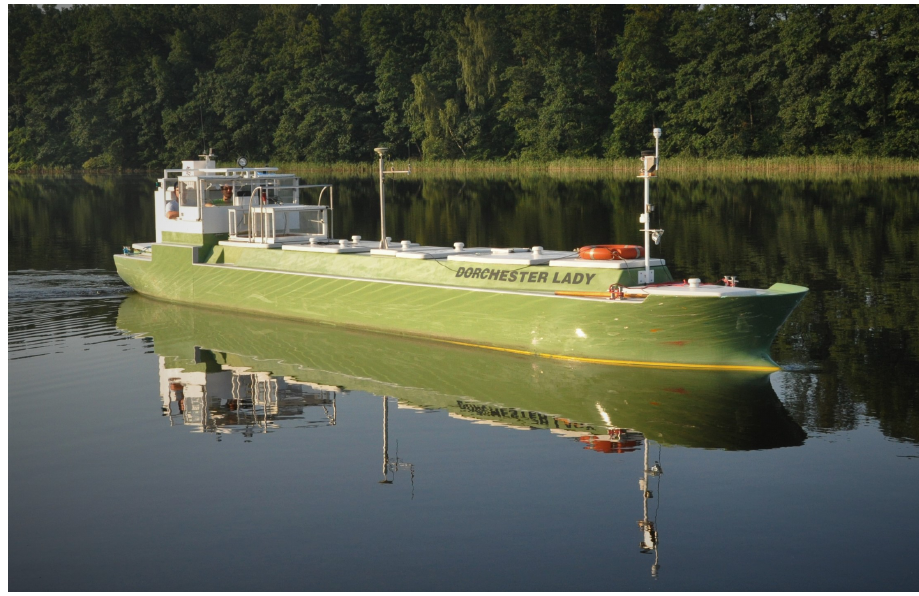
Figure 1. “Dorchester Lady” training ship—scale model of 113,500 Deadweight Tonnage (DWT) Liquefied Natural Gas (LNG) carrier.